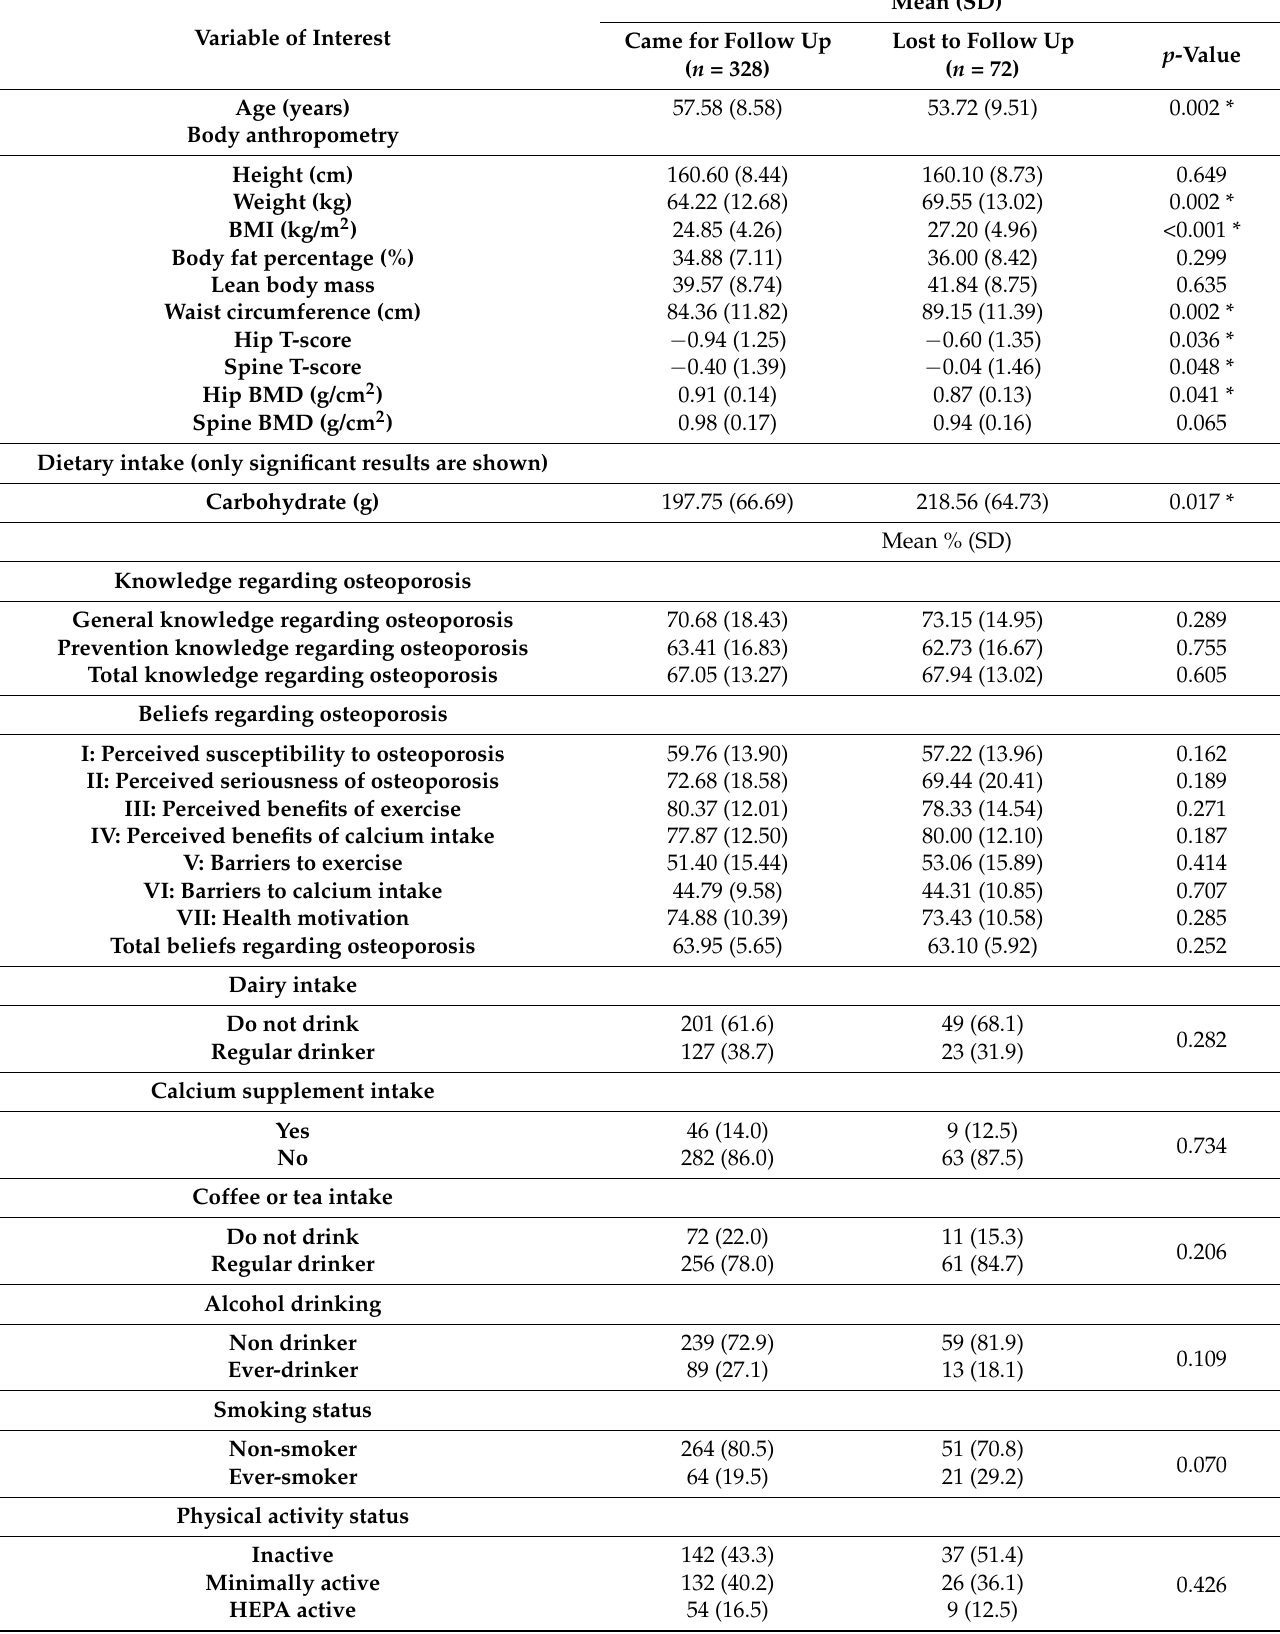
Table 2. Characteristics of subjects compliant with or lost to